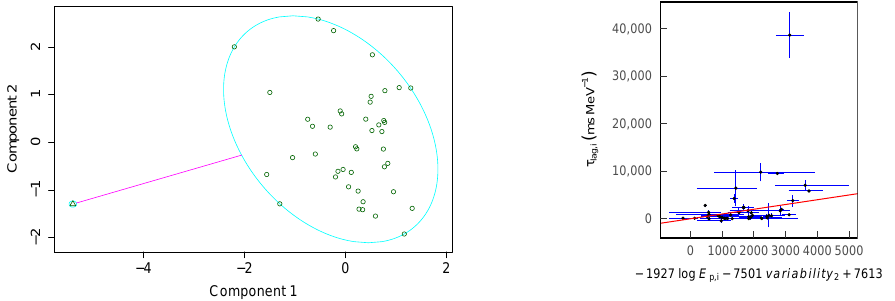
Figure 8. Similar to Figure 1, with the three parameters being τ lag,i , E p,i and variability 2 . The outlier is GRB 980425B. The linear regression result is τ lag,i = ( − 1927 + 490 − ) . The adjusted R 2 is variability 2 + ( 7613 + 570 − 1400